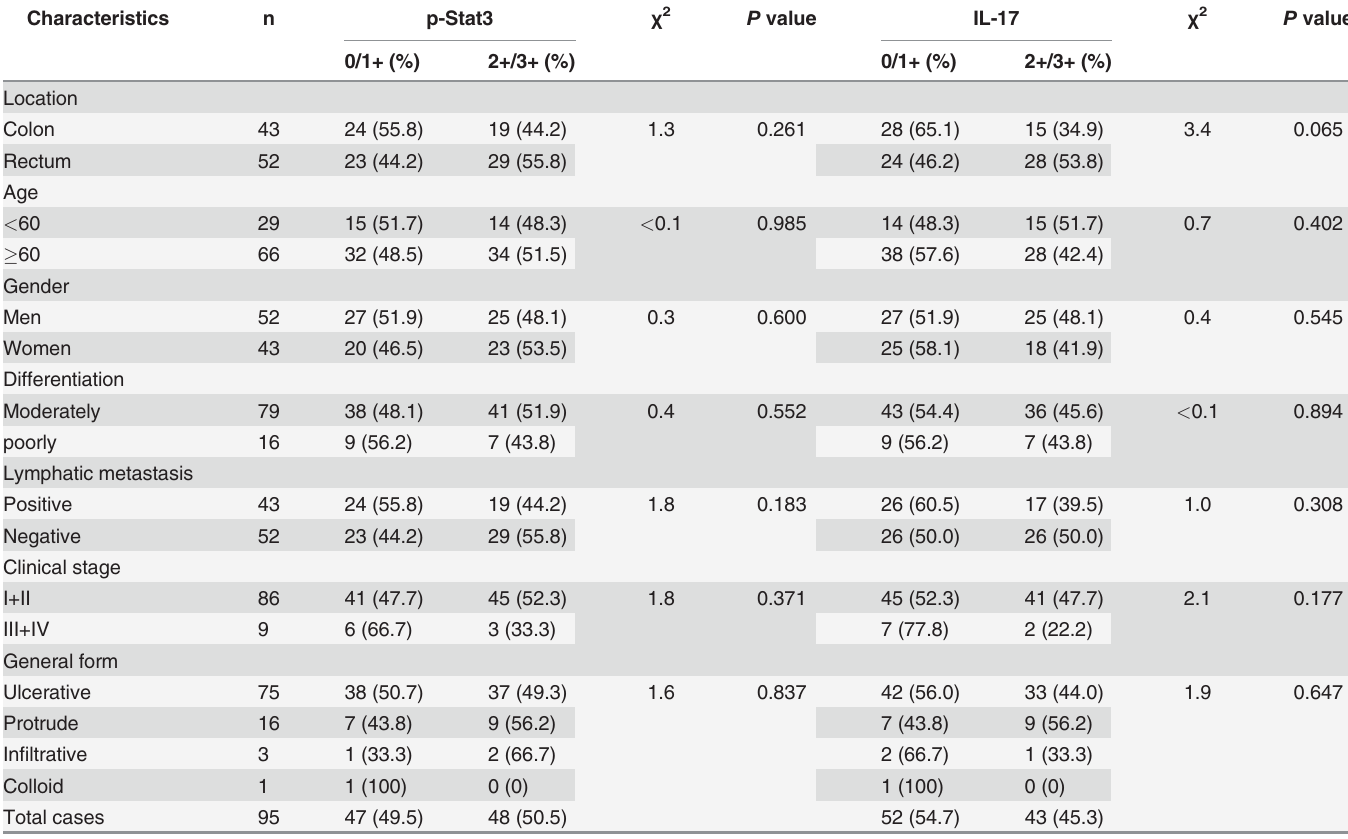
Table 5. p-Stat3 and IL-17 Expression Are Not Correlated with CRC Patients ’ Clinicopathological Characteristics.